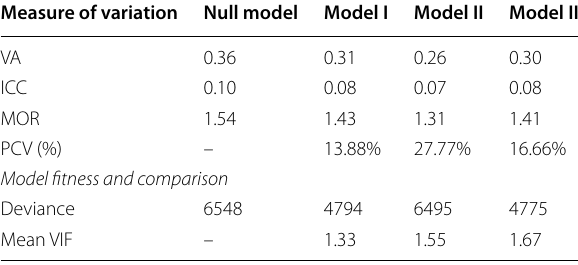
Table 2 Random effect analysis result